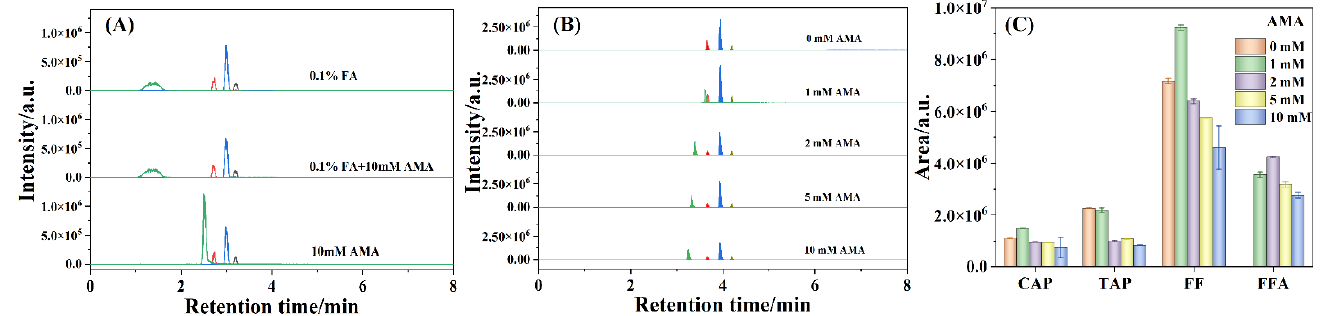
Figure 3. The chromatographic maps detected under different mobile phases ( A ) and varied con- centrations of AMA ( B ) and the histograms of chromatographic peak areas ( C ) of the 50 ng/mL amphenicols. The peaks from left to right: FFA, TAP, FF, and CAP.